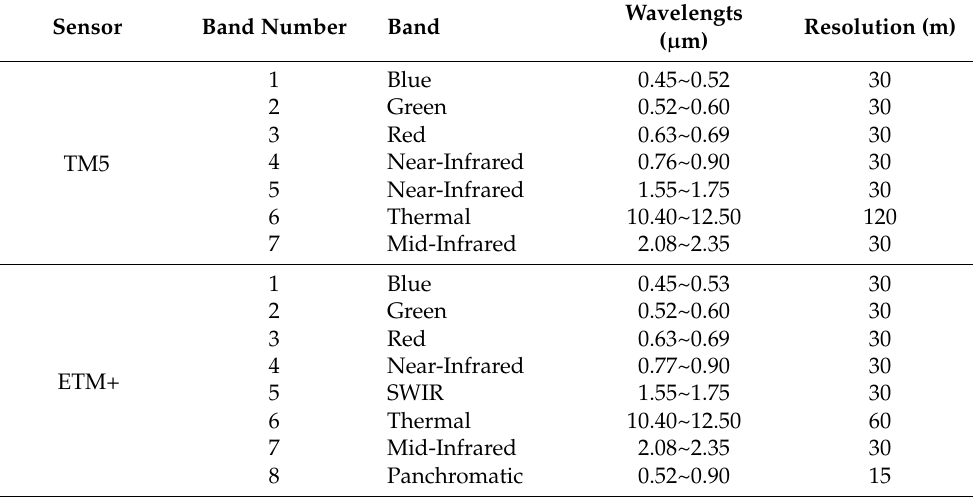
Table 3. Band, wavelengths and spatial resolution of Landsat TM5, ETM+, and OLI data.